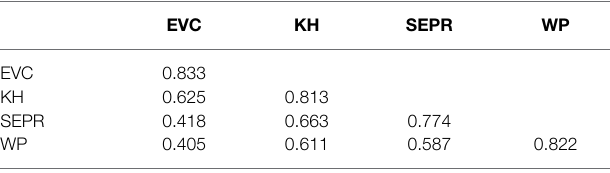
TABLE 2 | Discriminant validity (Fornell and Larcker criterion).